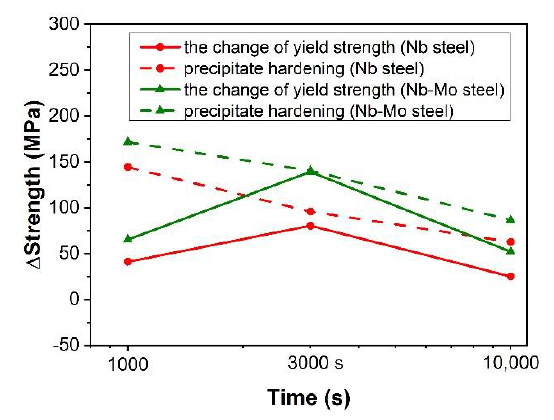
Figure 10. Comparison of the precipitation hardening using the maximum theoretical volume fraction and the change of yield strength for both steels after isothermal holding at 900 °C.